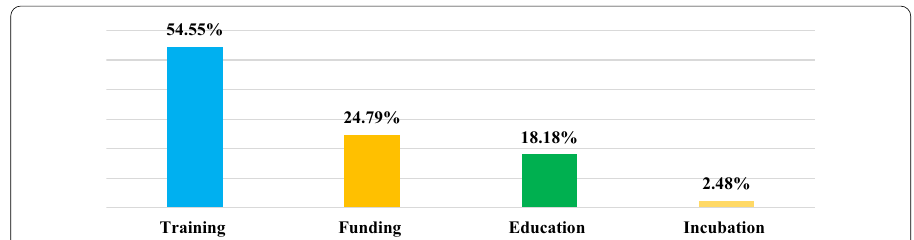
Fig. 12 Percentages of the services provided by the organizations providing one single service